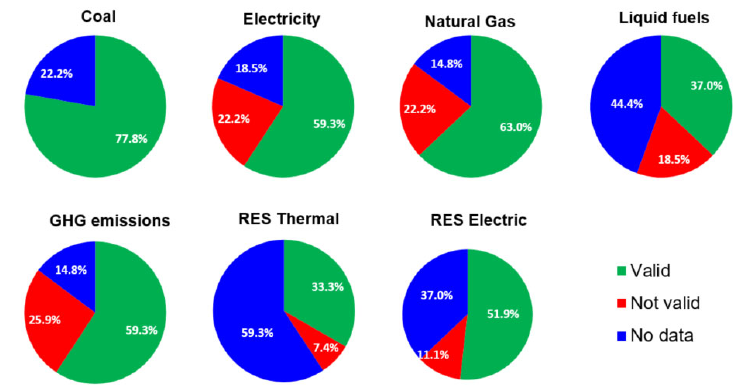
Figure 2. Data standardisation.